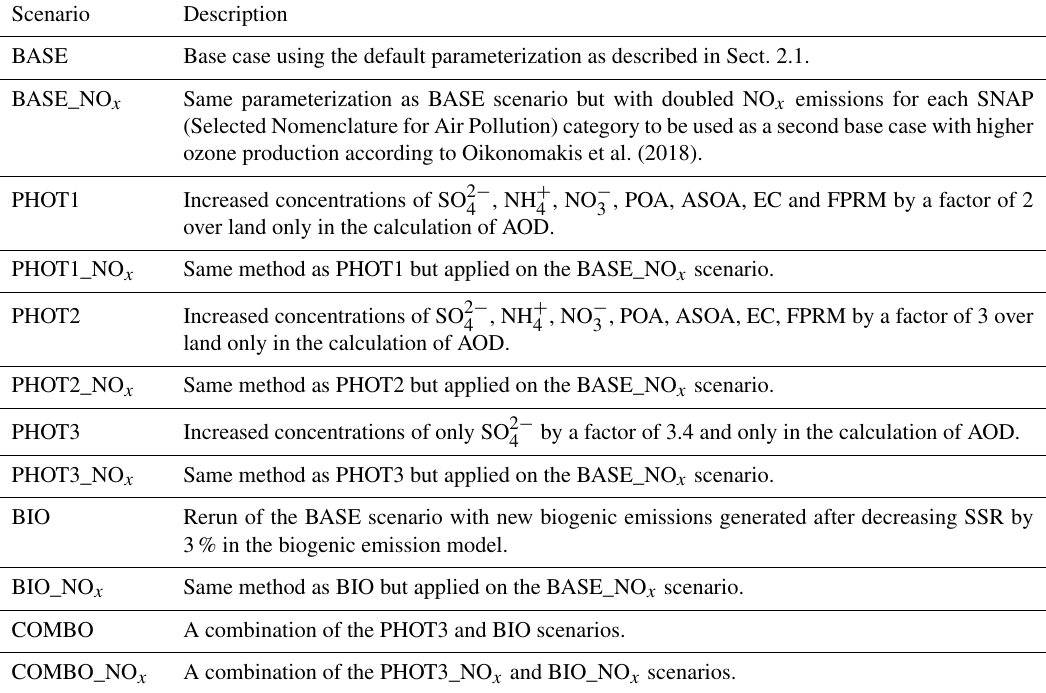
Table 1. Summary of model runs. All runs used the emissions and meteorology of 2010.